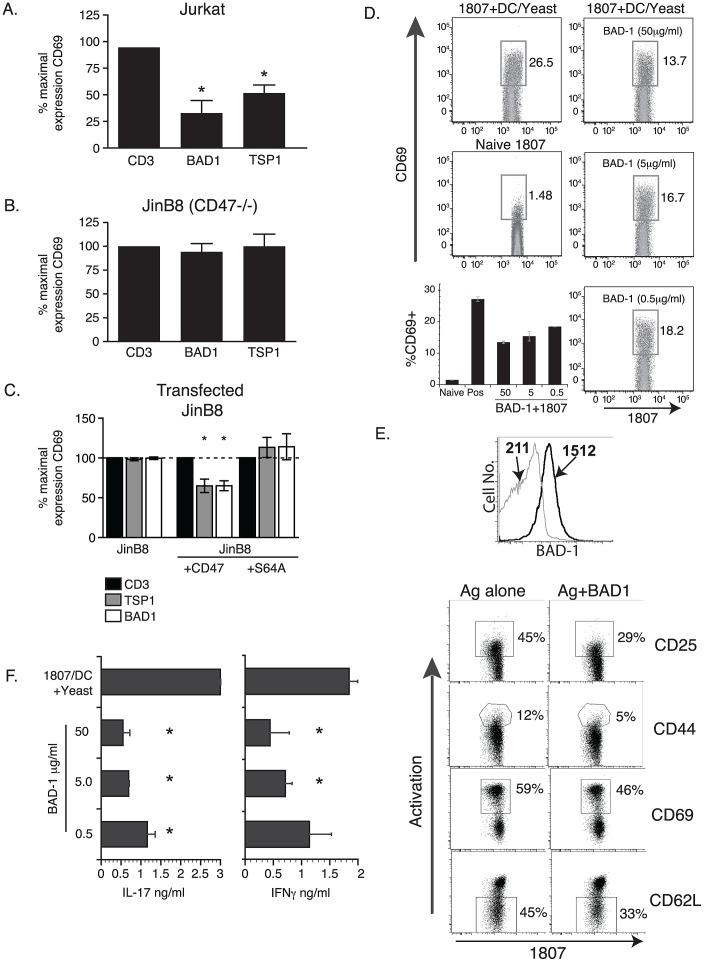
Suppression of T cell activation mediated by BAD-1 binding of CD47.
(A) BAD-1 inhibition of CD69 expression is dependent on CD47. Jurkat T cells were activated by anti-CD3 antibody alone (5 µg/ml) or in the presence of BAD-1 or TSP1 (10 µg/ml) for 2 hours in vitro. RNA was isolated and relative CD69 mRNA expression determined by real-time PCR. (B) JinB8 T cells lacking CD47 were activated by anti-CD3 antibody alone or in the presence of BAD-1 or TSP1 for 2 hours in vitro. RNA was isolated and relative CD69 mRNA expression determined as above. (C) Un-transfected JinB8 cells and cells transfected with CD47 and CD47-S64A were activated by anti-CD3 antibody alone or in the presence of BAD-1 or TSP-1 for 2 hours in vitro. RNA was isolated and relative CD69 mRNA expression determined as above. Values are percent activation relative to stimulated cells ± SD of 4 experiments for data in panels A–C; *, p<0.05. (D) CD4+ T cells from 1807 TCR Tg mice were exposed to increasing amounts of BAD-1 for 90 minutes, washed and added to co-culture of BAD-1 null B. dermatitidis yeast and DC for 96 hours. After incubation, the T cells were analyzed by flow cytometry for expression of CD69. (E) BAD-1 (50 µg/ml) was incubated with 1807 cells at 37°C for 90 min and analyzed by FACS with anti-BAD-1 mAb conjugated to FITC. In top panel, the numbers are the mean fluorescence intensity of mAb binding to control-treated (grey) vs. BAD-1-treated (black) cells. After incubating 1807 Tg cells as above, the T cells were added to wells containing DC and Blastomyces cell wall/membrane antigen (10 µg/ml). After 24 hours the cells were stained for the activation markers shown and analyzed by FACS. (F) Supernates were collected from co-cultures in panel D and assayed by ELISA for IL-17A and IFN-γ. *, p<0.05. vs. control. Results are representative of 2–4 independent experiments for panels D and E.